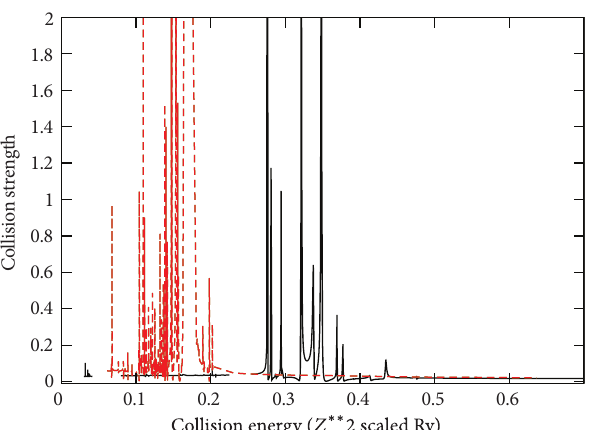
0 F 2: Collision strengths for the D e - P e transition of Co . e full curve corresponds to the calculation where 136 states arising from manifolds are included into the scattering process. e broken curve corresponds to the calculation where 272 the 5 3 3+ con�gurations are included into the scattering process. Scaled units are used for the collision states arising from , with energy: for positively charged ions energies are scaled by a factor 1/ 3𝑑𝑑 4𝑑𝑑 𝑍𝑍